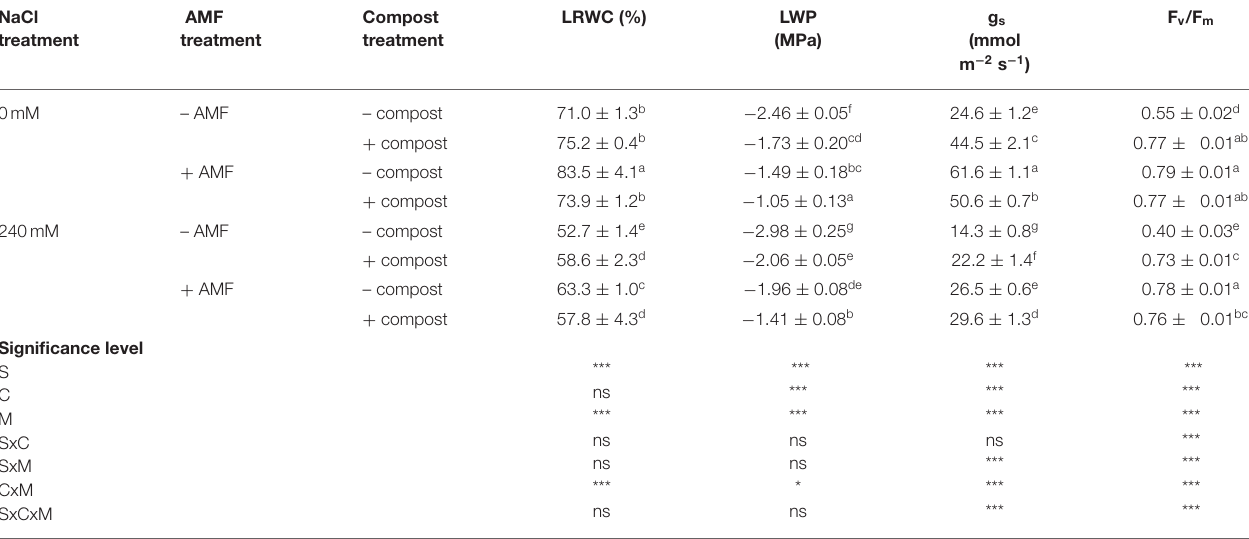
TABLE 3 | Physiological traits and water status of date palm plants under saline and non-saline conditions after application of compost and AMF alone or in combination. NaCl